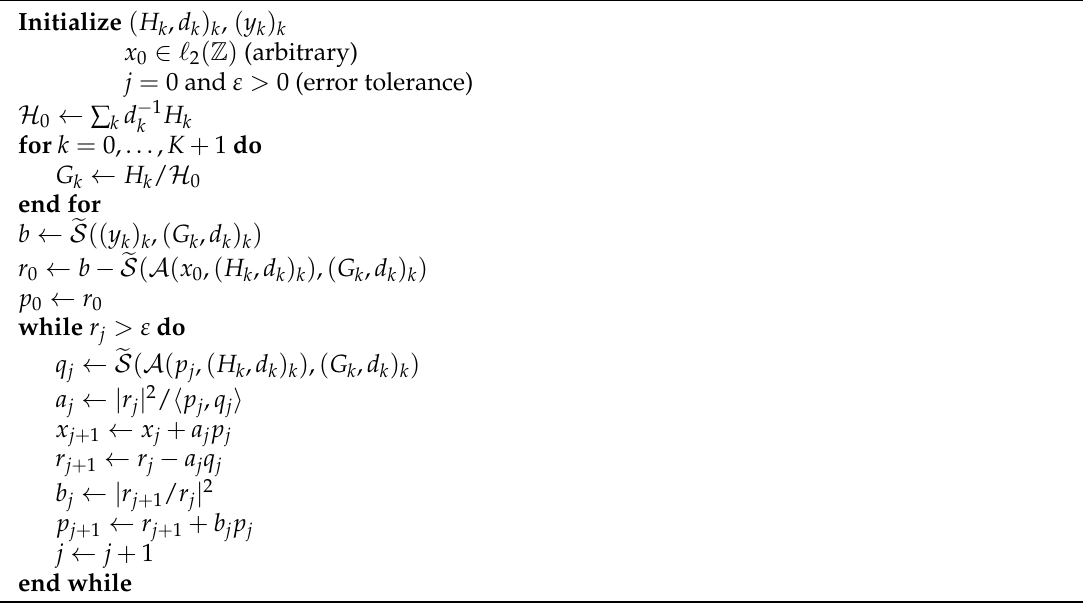
Algorithm 1 Synthesis by means of conjugate